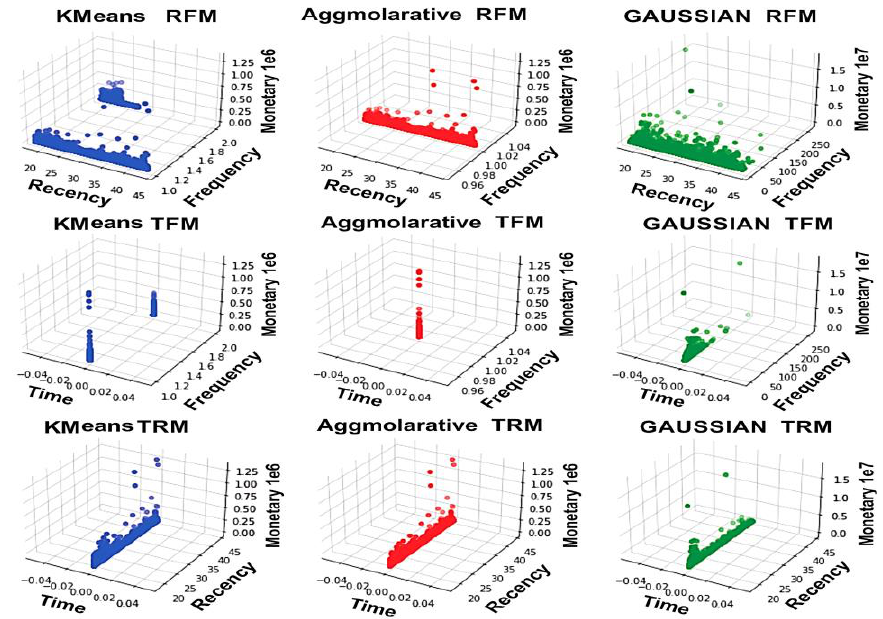
Figure 4. Customer distribution in the three or two clusters of RFMT in different algorithms in cluster C2.